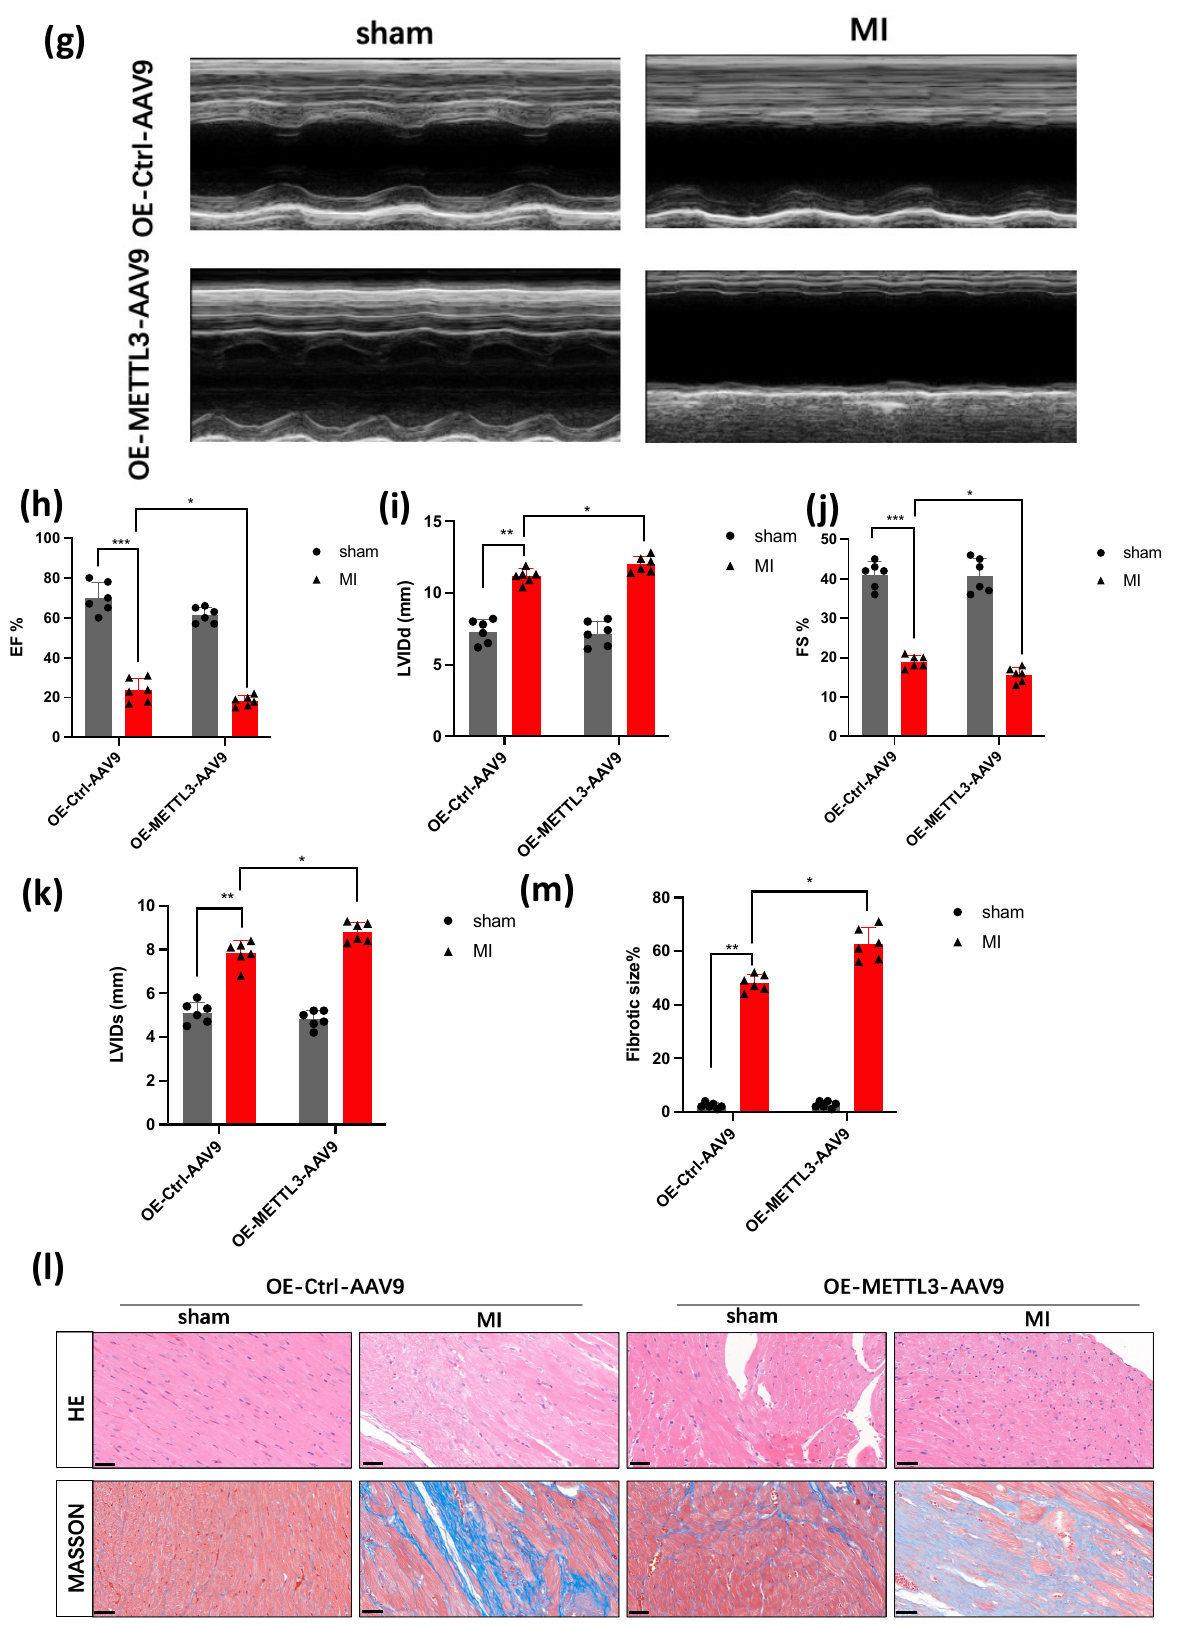
Figure 2. METTL3 overexpression promotes the deterioration of cardiac function. ( a ) qPCR demonstrated the overexpression of METTL3, scar bar: 50 um, ( n = 7); ( b ) western blot demonstrated the